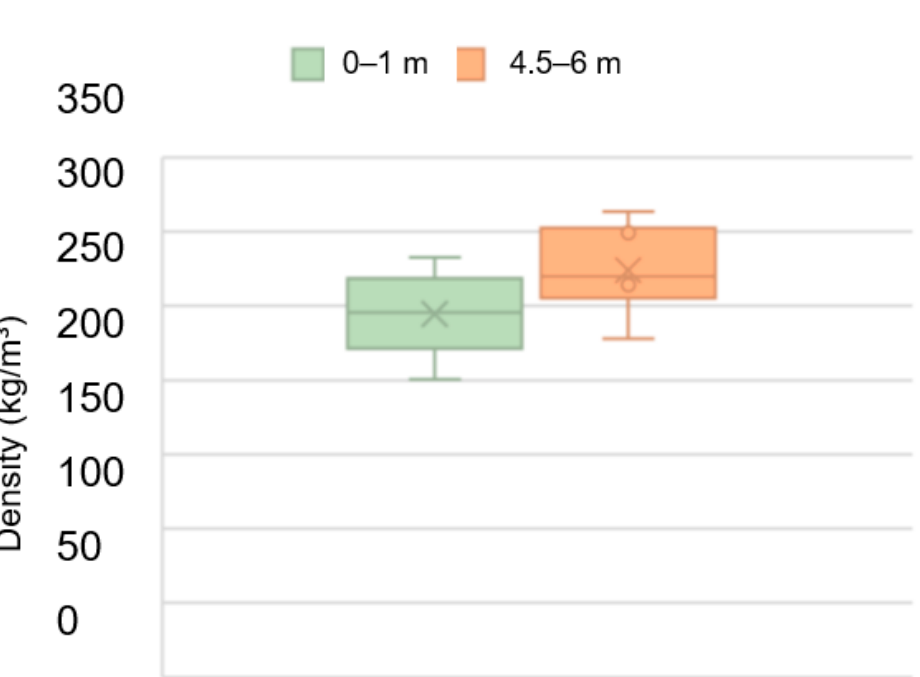
Figure 6. Density of Paulownia samples depending on the position in the tree trunk (0–1 m, 4.5–6 m).